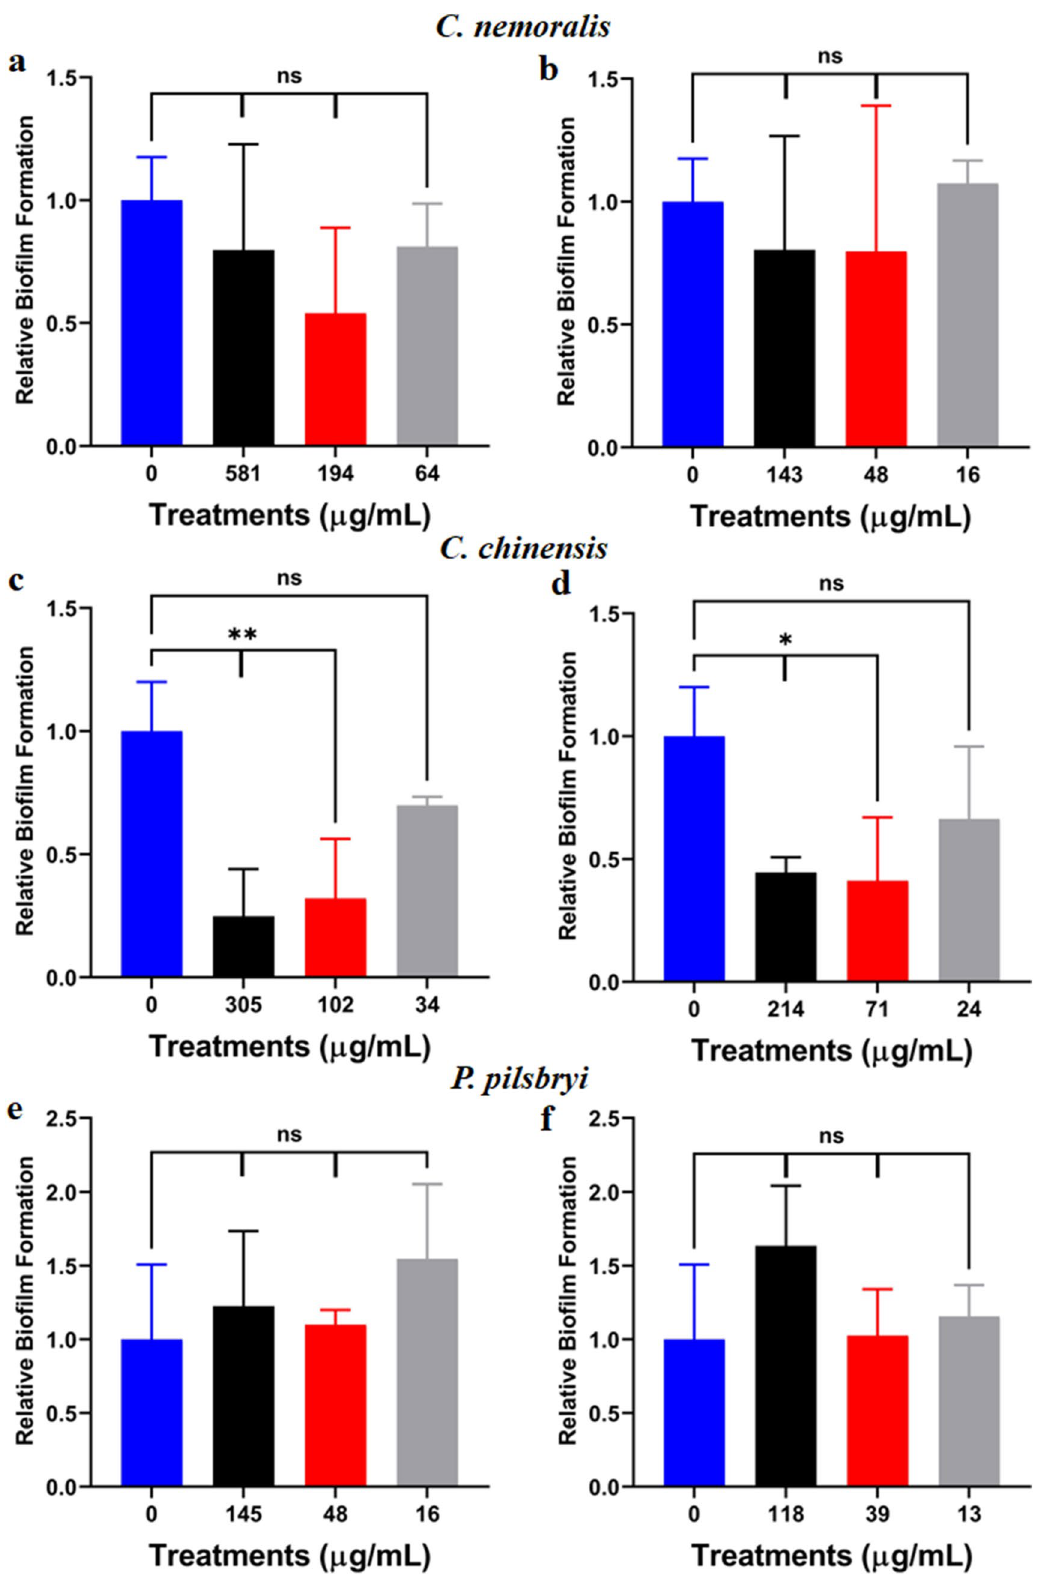
Figure 2. Changes to C. neoformans biofilm formation in the presence of mollusk extracts at 37 °C. ( a ) and ( b ) Effect of crude and clarified extracts from C. nemoralis , respectively; ( c ) and ( d ) Effect of crude and clarified extracts from C. chinensis , respectively and ( e ) and ( f ) Effect of crude and clarified extracts from P. pilsbryi , respectively. Biofilm formation on each condition was normalized to a control without any extract (0 µg/mL). Experiments were performed in biological triplicate and technical duplicate. Error bars indicate standard deviation. Statistical analysis was performed using a one-way ANOVA and a Dunnett’s multiple comparison test with a p-value of 0.05. **p < 0.01; ***p < 0.001 and ****p < 0.0001. Figures were created using GraphPad Prism